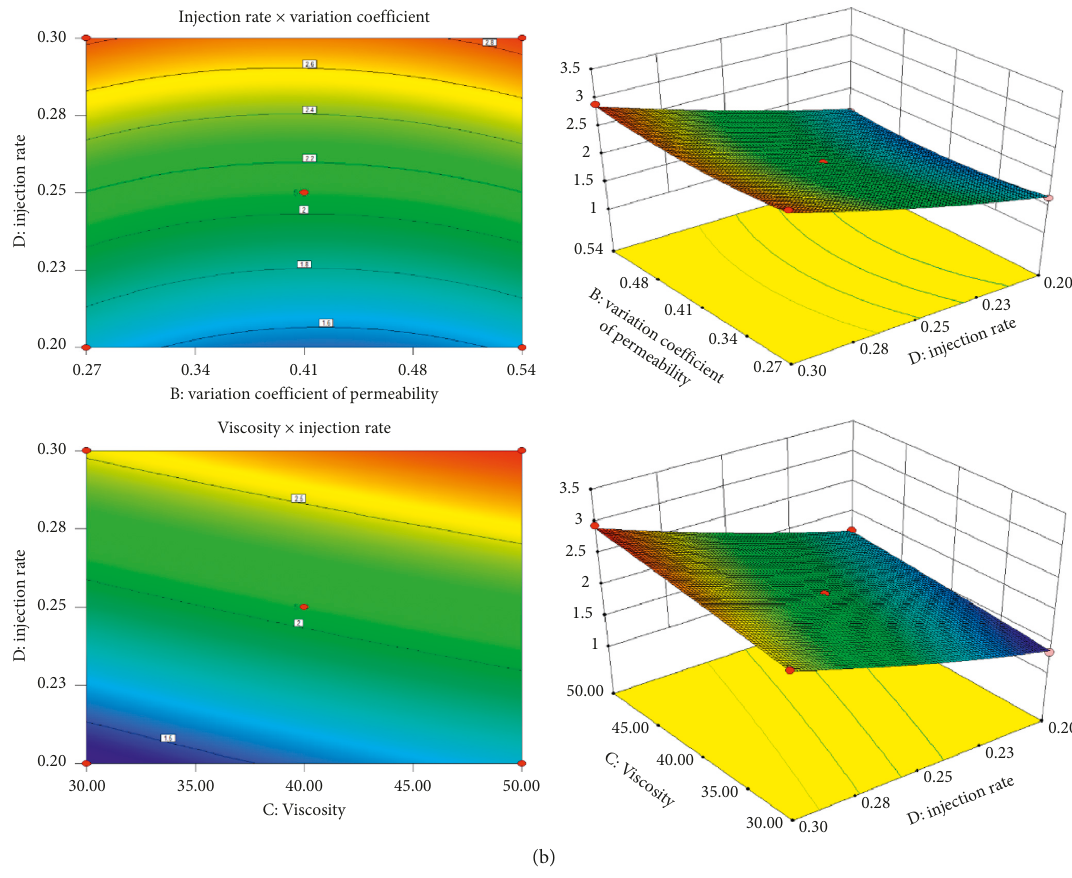
Figure 30: The response surface